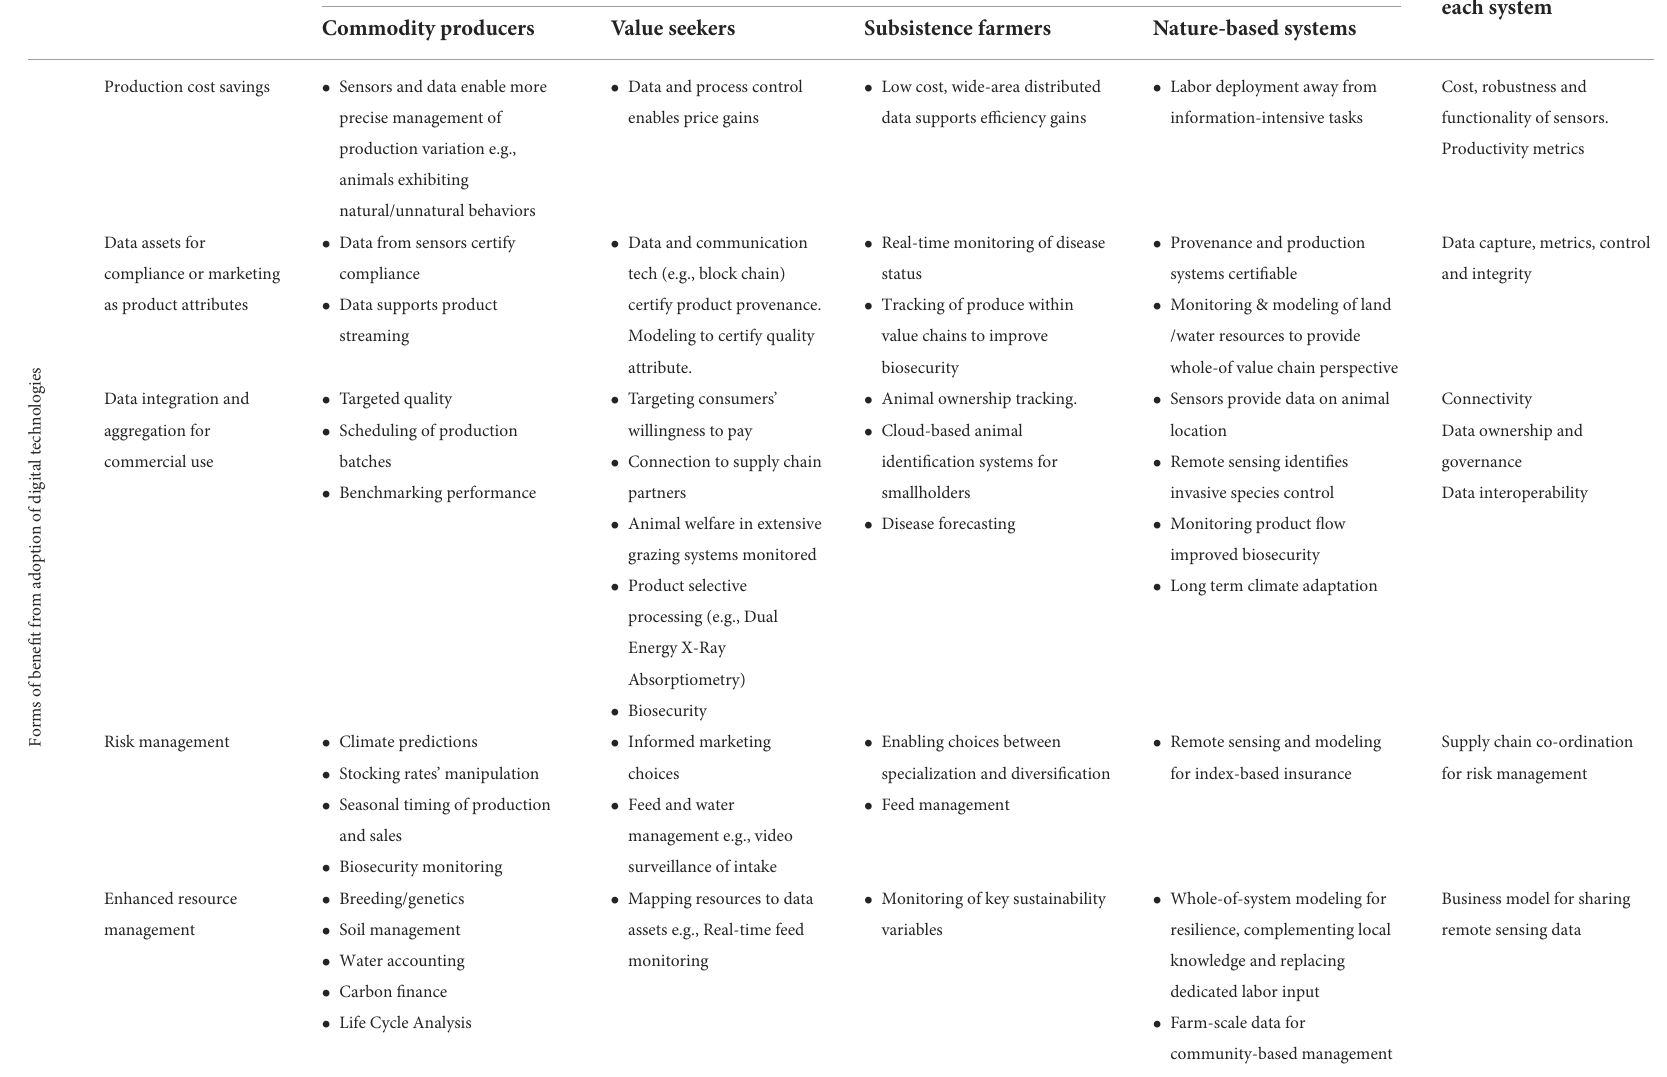
TABLE 1 General function of digital technologies for animal health, animal welfare and product quality in systems for the four classes of